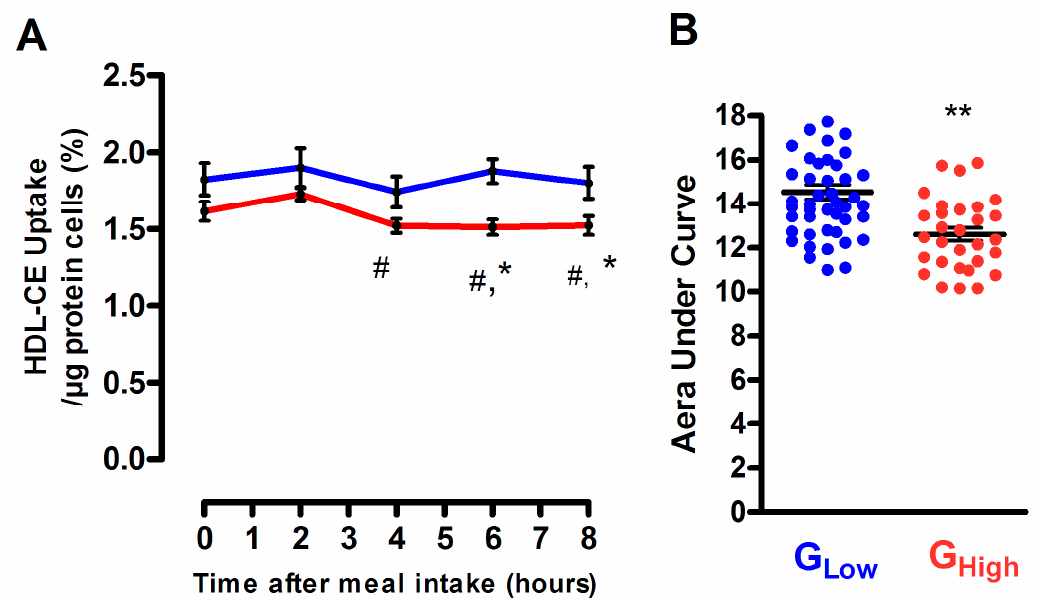
Figure 6. Postprandial time course of the in vitro capacity of postprandial HDL particles isolated from subjects with a desirable postprandial TG response, G Low (blue curve) and with an undesirable postprandial TG response, G High (red curve) to deliver CE to HepG2 cells ( A ). Area under the curve (AUC) in subjects from G Low (blue dots) and G High (red dots) ( B ). Values are mean ± SEM. ** p < 0.002 and * p < 0.05 versus G Low . # p < 0.05 versus before meal